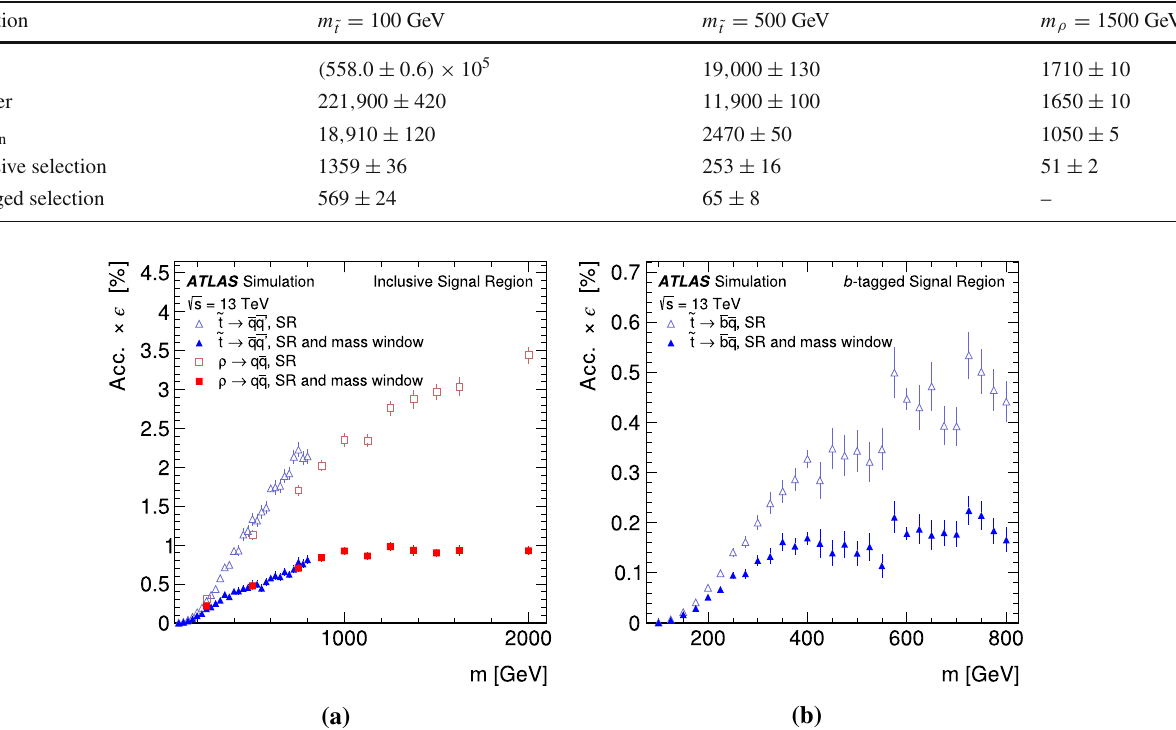
Top squark signals are indicated by the blue triangles, coloron by the red squares. The statistical uncertainties are indicated by vertical